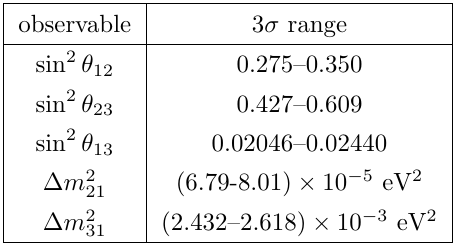
Table 2 . The 3 (cid:27) ranges of neutrino oscillation parameters for the normal hierarchy case from NuFIT 4.1 (2019) [40,